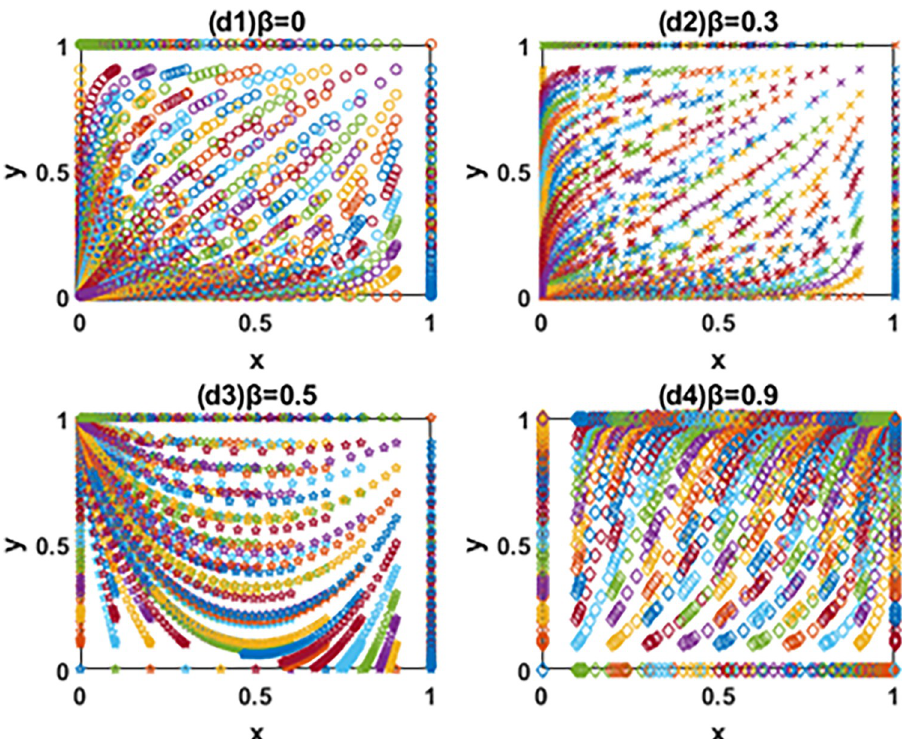
Fig 9. Effects of β on the path selection of